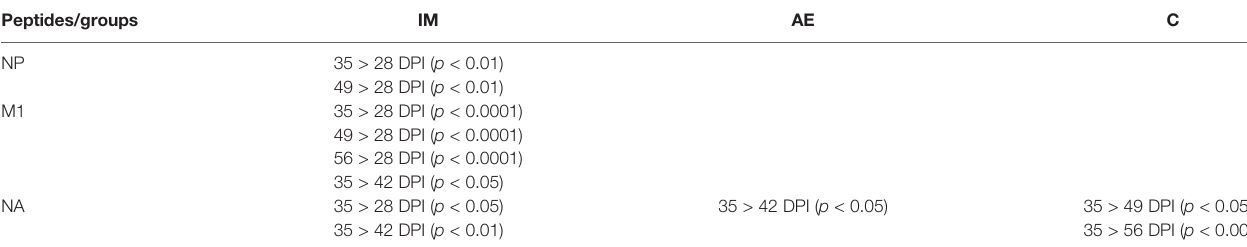
TABLE 3 | Signi fi cant differences in the same group between different time points after immunization for .